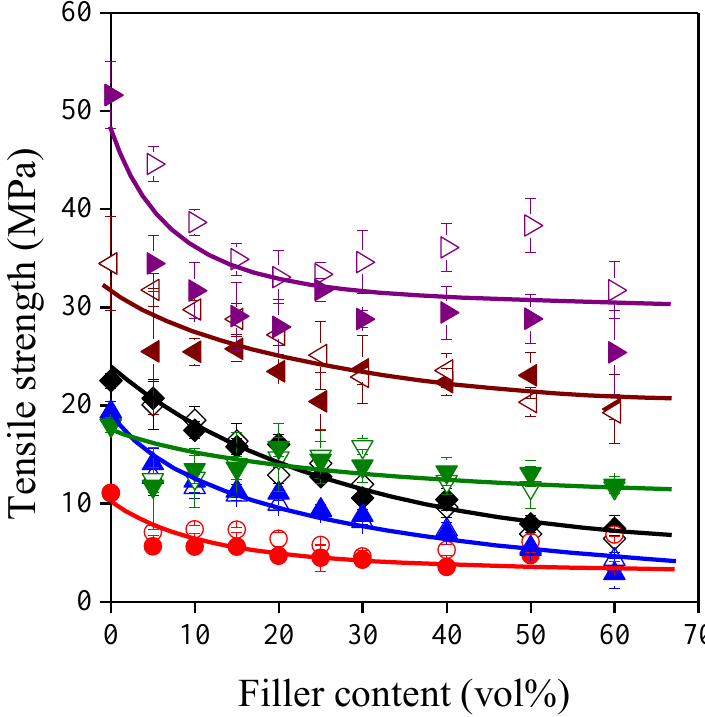
Figure 3. Physical contact between the sunflower husk particles in HDPE composites. Arrows show some physical contact points. The white scratches are the imprints of the steel mold. Filler content: 40 vol%. ( a ) SP20; ( b ) SPF. 3.2. Performance at Failure The practical relevance of a composite material is demonstrated not only by its mod- ulus but also by the mechanical properties measured at failure, such as strength and de- formation-at-break. In Figure 4, tensile strength is plotted against sunflower husk content. In all cases, strength decreases with increasing filler loading, but the gradient of the tendencies is quite different. On an absolute scale, the strength of PLA based composites decreases drastically, while that of LDPE and PS based ones changes slightly. The decrease of strength is often considered to be a consequence of weak interfacial adhesion between the matrix polymer and the filler. However, strength is affected not only by interfacial interactions but also by matrix [60] and filler properties [61], as well as by structure [62],